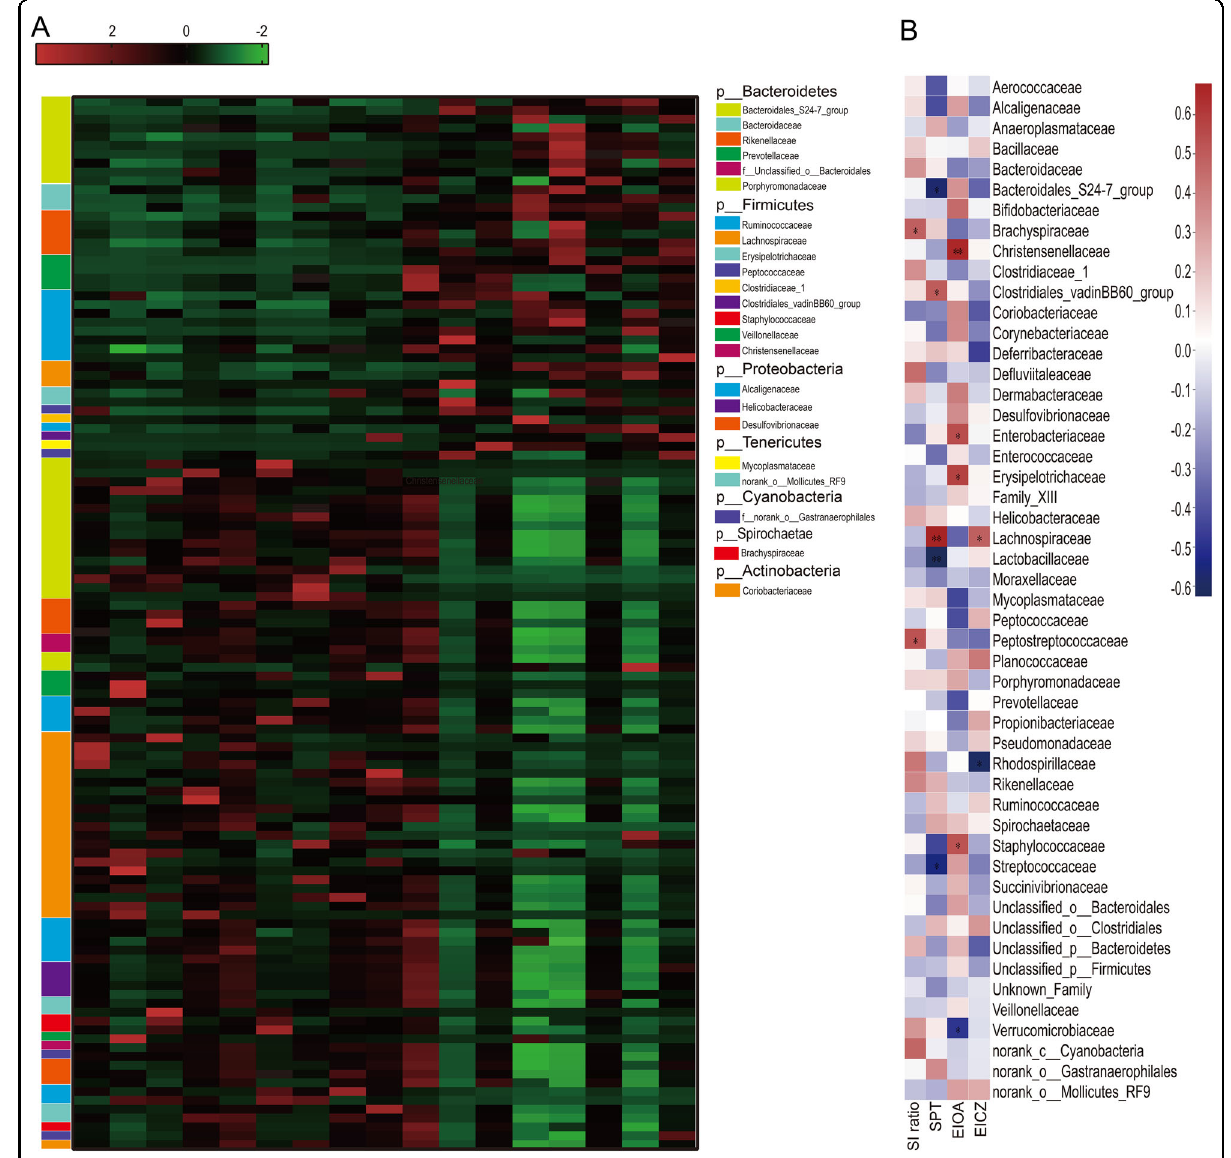
Fig. 4 The most differentially abundant taxa between the two groups. a Heatmap of the 119 discriminative OTU abundances between WT and CD36 − / − mice (LDA > 2.0). OTUs (raw) were sorted by taxa and enrichment. The intensity of the color (green to red) indicates the score normalized abundance for each OTU. b Associations of gut microbial family with behavioral phenotype. Heat map of Spearman ’ s rank correlation. Red squares indicate positive associations between microbial family and behavioral phenotype; blue squares indicate negative associations. The statistical signi fi cance level is indicated in the squares ( n = 8 – 9 mice/group, * P < 0.05). SPT sucrose preference test, EIOA entrance in open arms, EICZ entrance in center